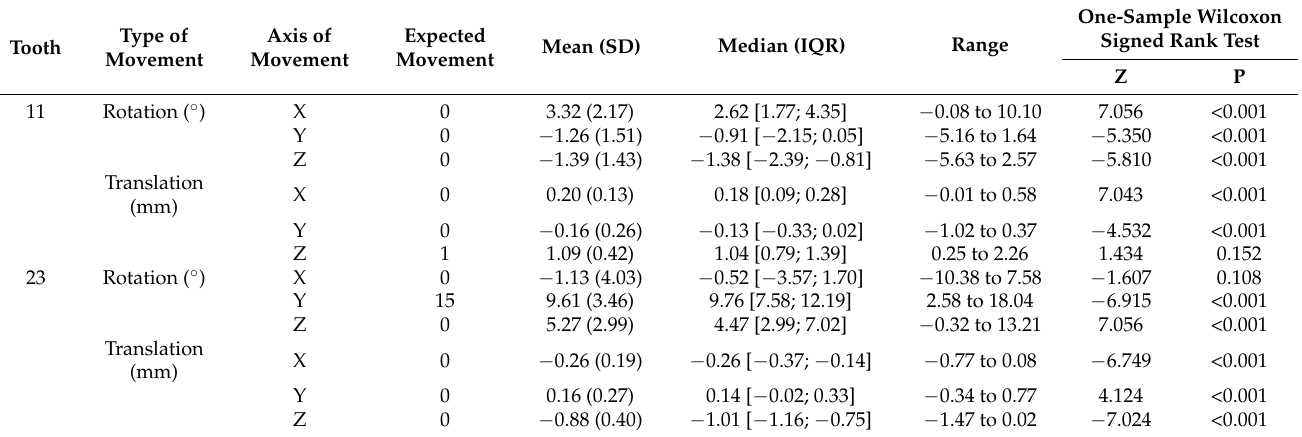
Table 1. Descriptive and inferential statistics of 1 mm translational vestibular ( Z -axis) movement of tooth 11 and 15 ◦ mesial rotation ( Y -axis) of tooth